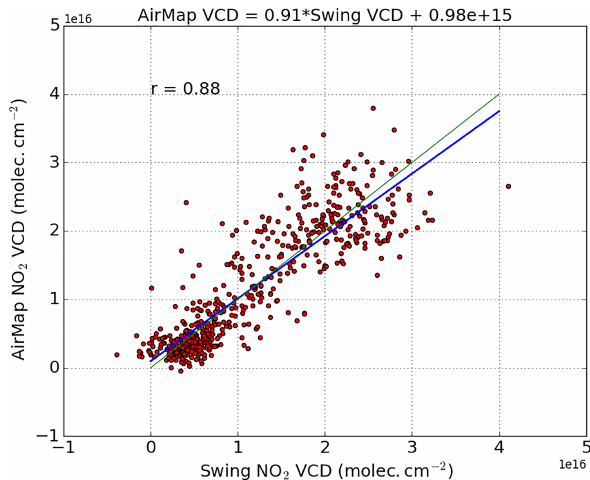
Figure 12. Scatter plot of collocated SWING and AirMAP NO 2 vertical columns.